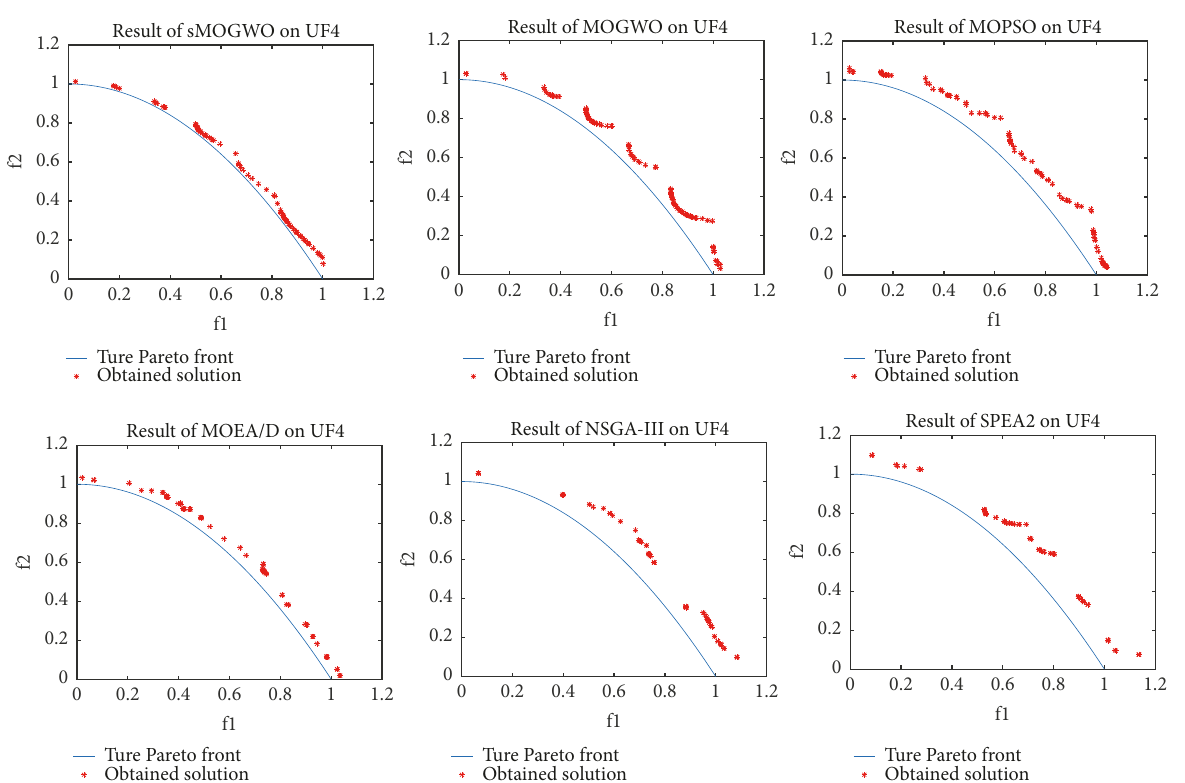
Figure 8: The best optimal results of the different algorithms in repeated experiments on